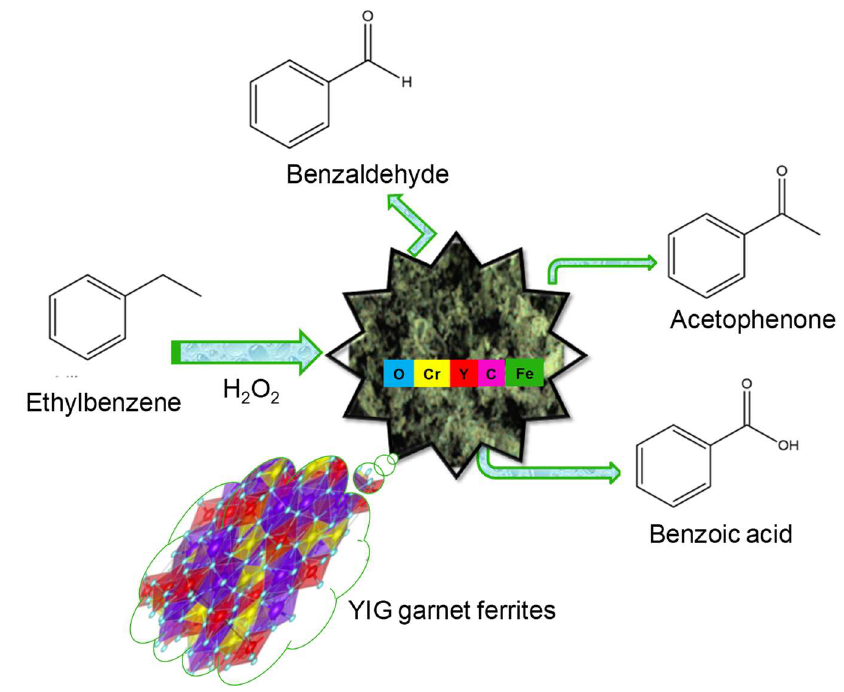
Figure 1. Scheme of the ethylbenzene oxidation reaction in the presence of H 2 O 2 catalyzed by the YIG garnet ferrites. YIG garnet